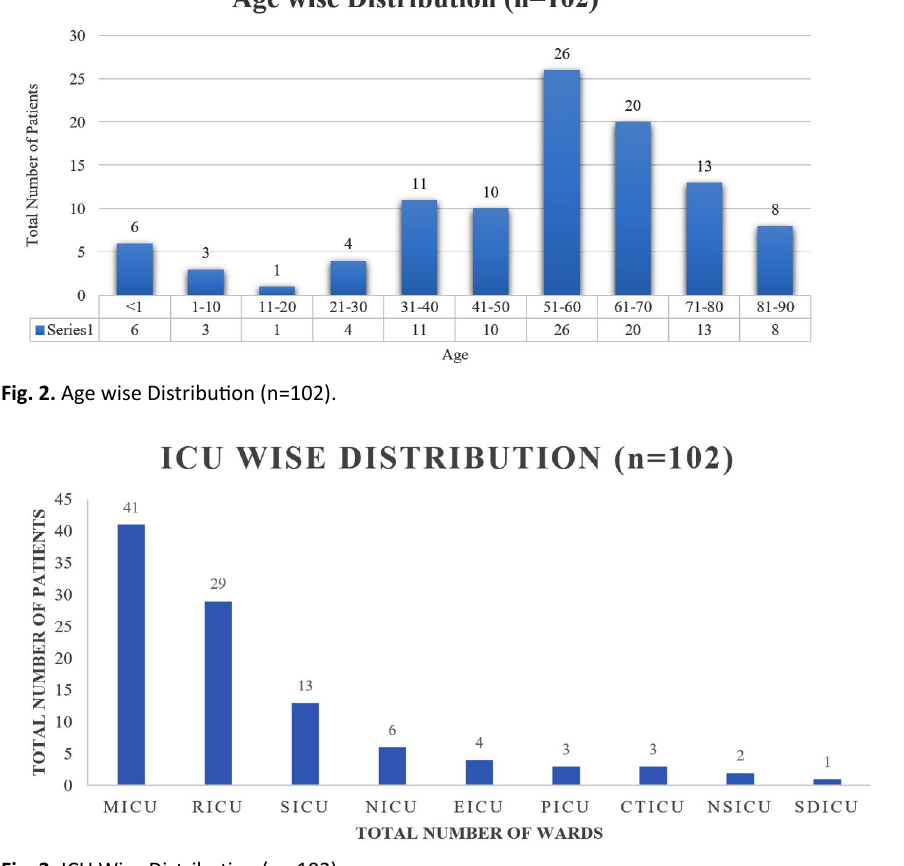
Fig. 3. ICU Wise Distribution (n= 102).